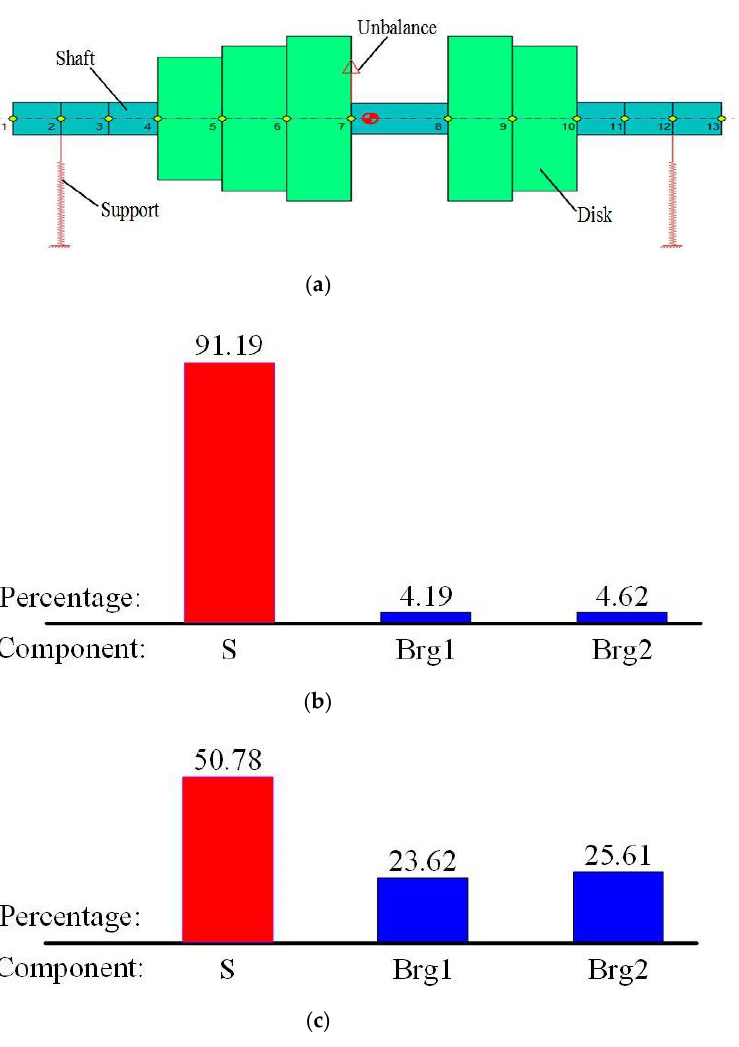
Figure 6. Rotor system and energy distribution with different supports: ( a ) Rotor system with supports; ( b ) Rigid supports; ( c ) ISFBD supports.